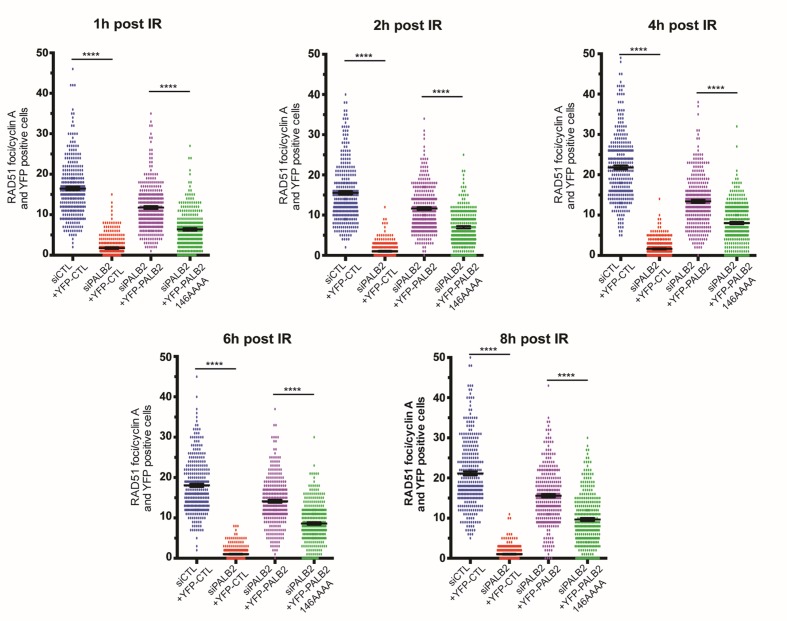
Time dependence of RAD51 foci formation after DNA damage in the experiment described in Figure 3.Cells were prepared as described in Figure 3 and processed for immunofluorescence at 1 hr, 2 hr, 4 hr, 6 hr and 8 hr post-irradiation.